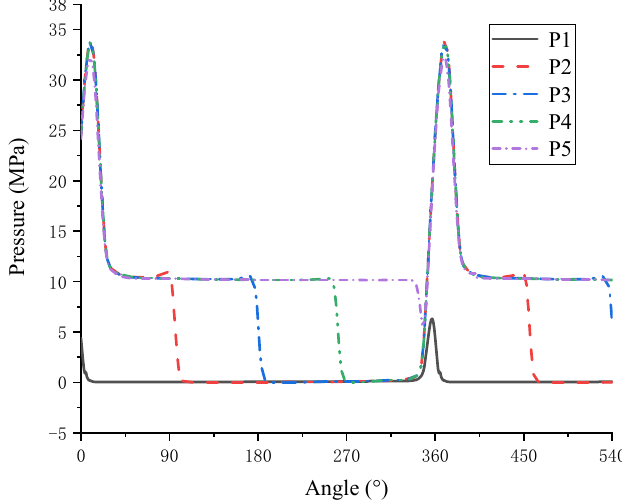
Figure 8. Pressure curve of monitoring points.